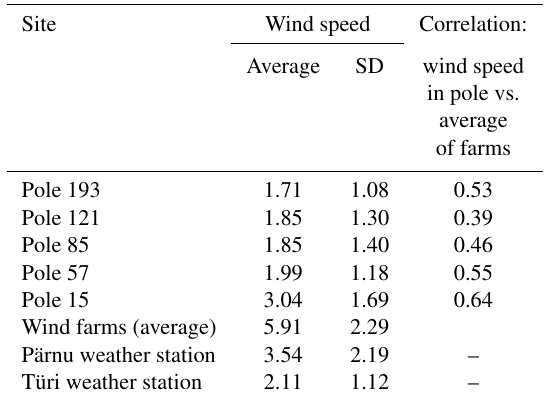
Table 1. Averages and standard deviations of wind speeds through the observation period. Linear correlation coefficients are given only for 5min averages, not for weather station (hourly) data.